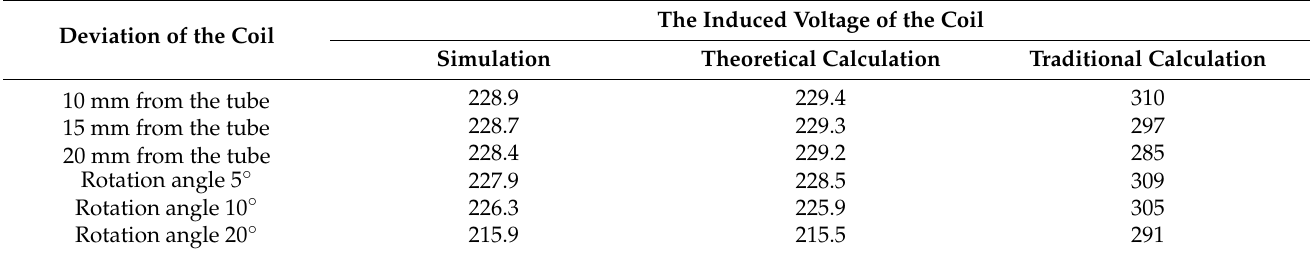
Table 2. Comparison of calculation formula and